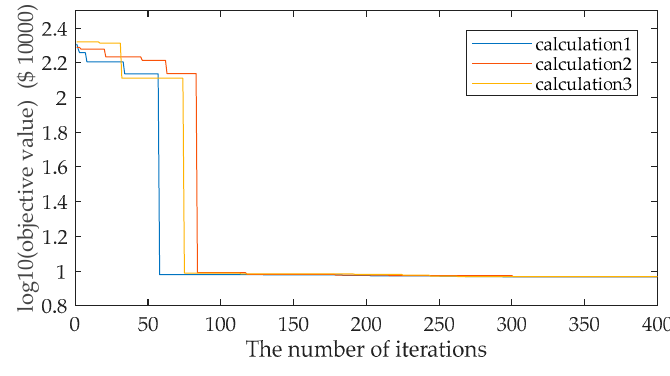
Figure 7. Iteration process of the proposed algorithm.